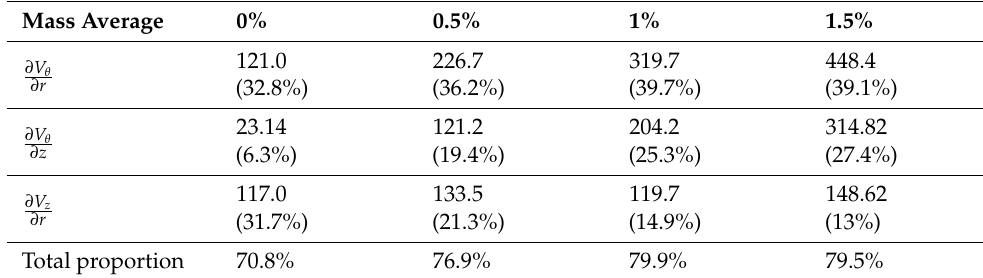
Table 6. Velocity gradient for variety IR